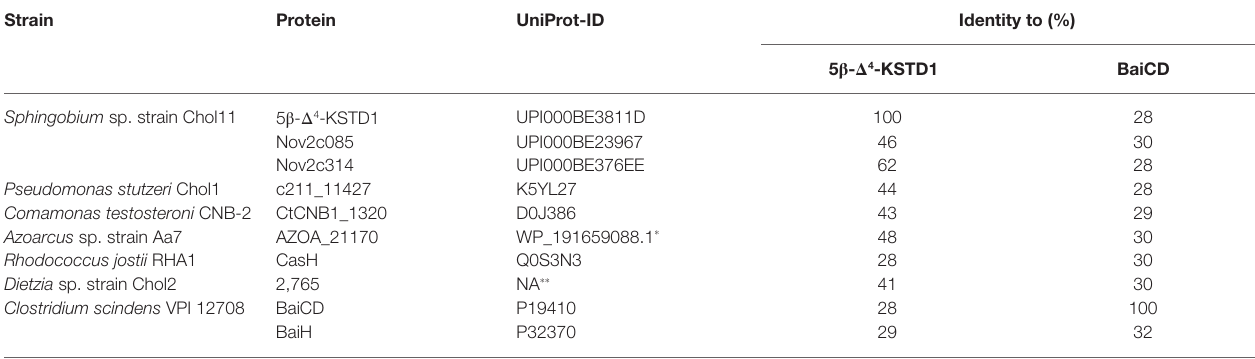
TABLE 3 | Homologs of 5 β - Δ 4 -KSTD1 in several known bile-salt degrading organisms and their identity to 5 β - Δ 4 -KSTD1 and BaiCD. Strain